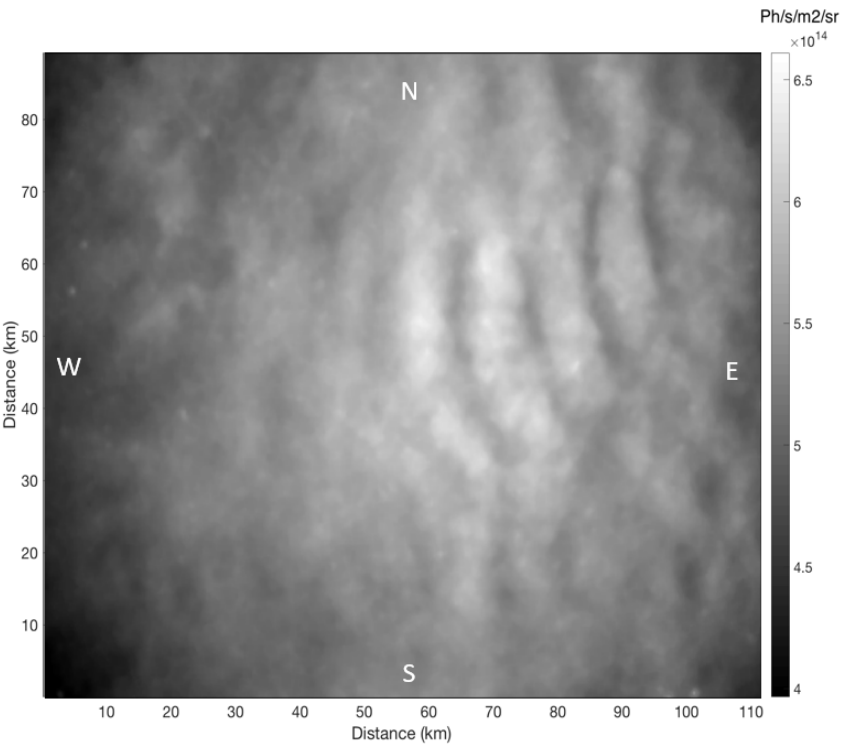
Figure 2. Corrected image of the OH radiation at 87 km altitude acquired during the night of 12–13 December 2017 [20]. The radiance scale is in ph/s/m 2 /sr. North is at the top of the image, west is on the